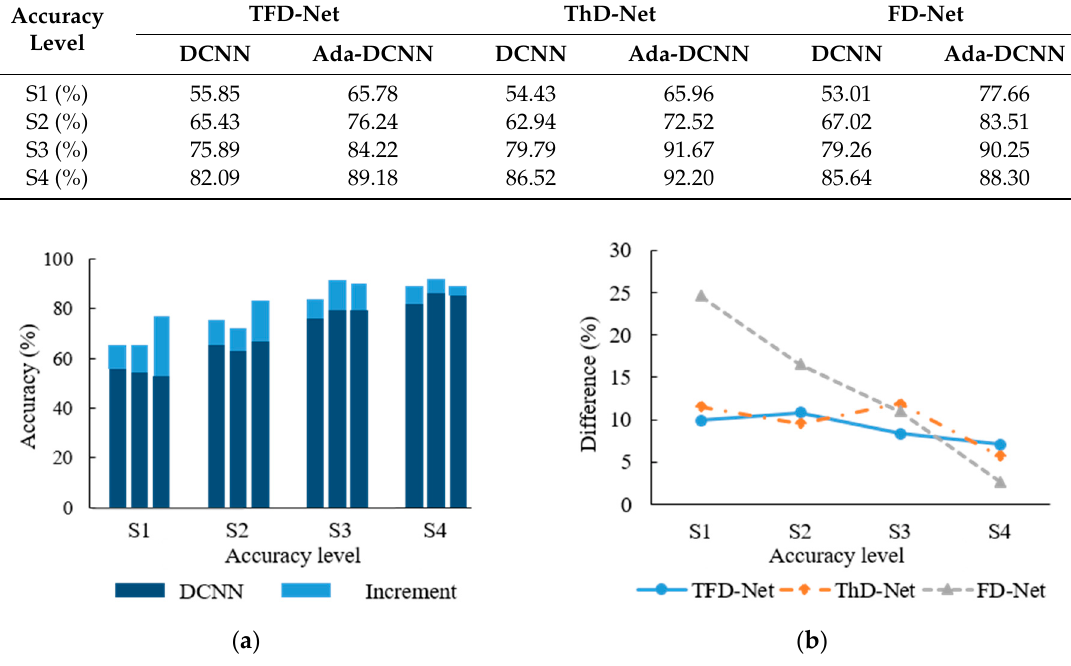
Figure 9. Comparison between DCNNs and Ada-DCNNs in 4 accuracy levels: ( a ) Accuracy of DCNNs as well as the increment by Ada-DCNN in 4 accuracy levels; ( b ) Difference of accuracy between DCNNs and related Ada-DCNNs in 4 accuracy levels.